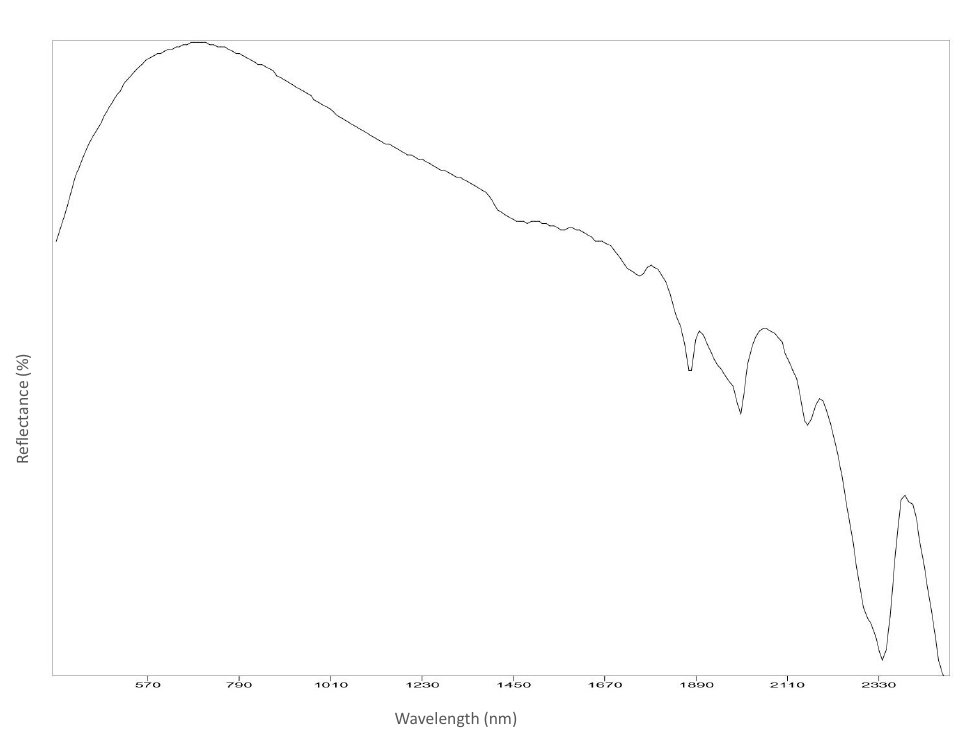
Figure A8. Back-right.